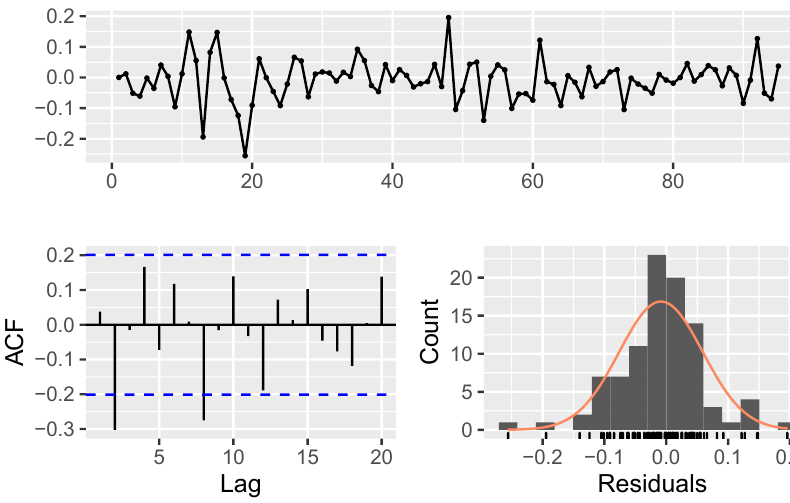
Figure A6. Residuals from ARIMA(1,1,1) for Stock